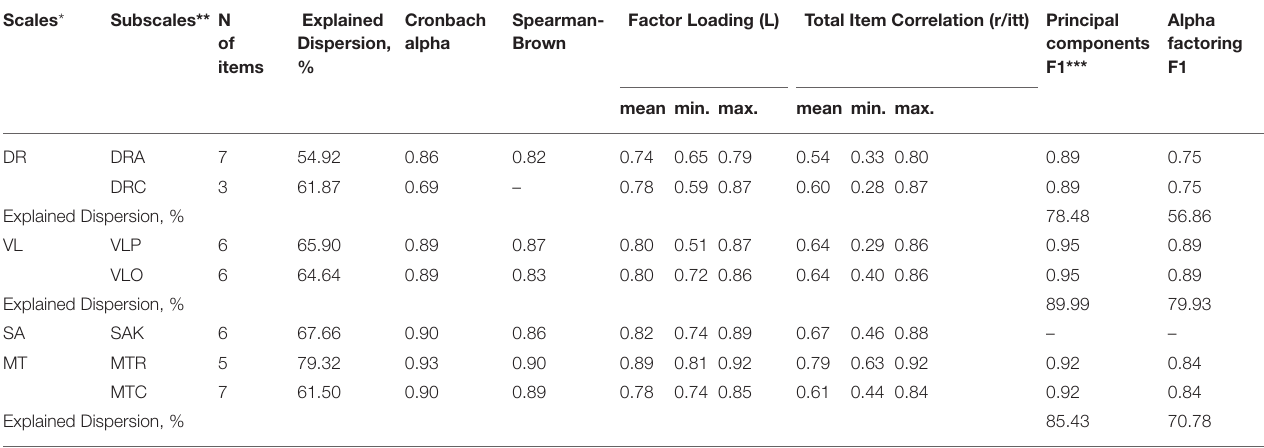
TABLE 1 | Psychometric characteristics of the instrument “Motives of Persons Aggrieved at Work for Seeking Spiritual Assistance (MP-SSA-40)”: prime and secondary factorization. Scales * Subscales** N of